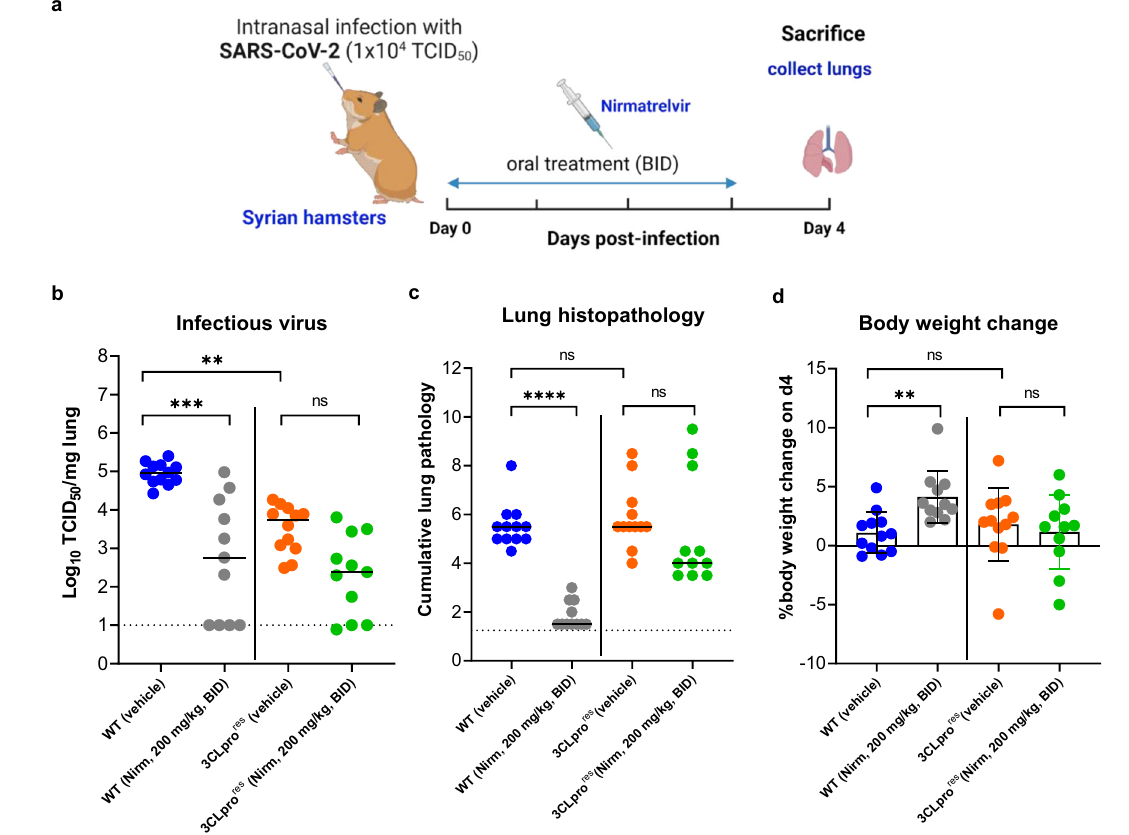
Fig. 3 | In vivo ef fi cacy of nirmatrelvir against the 3CLpro (L50F-E166A-L167F) resistant virus. a Set-up of the study. b Infectious viral loads in the lungs of hamsters that were treated with vehicle or nirmatrelvir (Nirm) at 200mg/kg (BID) and infected with 10 4 TCID 50 of eitherthewild-type (WT)SARS-CoV-2isolate (USA- WA1/2020) or the 3CLpro (L50F-E166A-L167F) nirmatrelvir resistant (3CLpro res ) virus at day 4 post-infection (pi) are expressed as log 10 TCID 50 per mg lung tissue. Individualdataandmedianvaluesarepresented. c Cumulativeseverityscoreatday 4p.i.from H&Estained slidesof lungs from hamsterstreated with either vehicle or